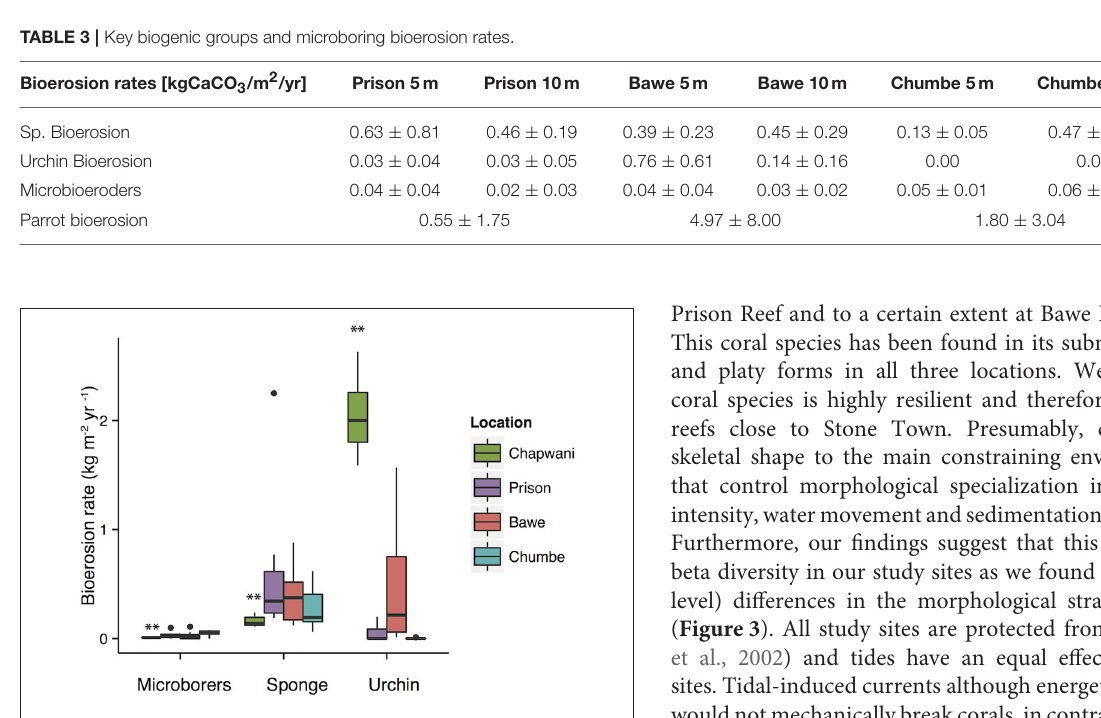
FIGURE 5 | Boxplots showing the bioerosion rates calculated for the different biogenic groups. The locations include Chapwani (green), Prison (purple), Bawe (red), and Chumbe (blue). ** p -values <